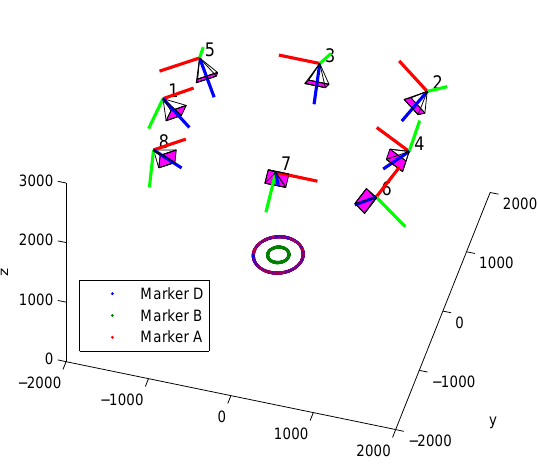
Figure 6. Trajectories of markers A, B and D. Camera locations and orientations obtained from the Vicon calibration wand procedure.